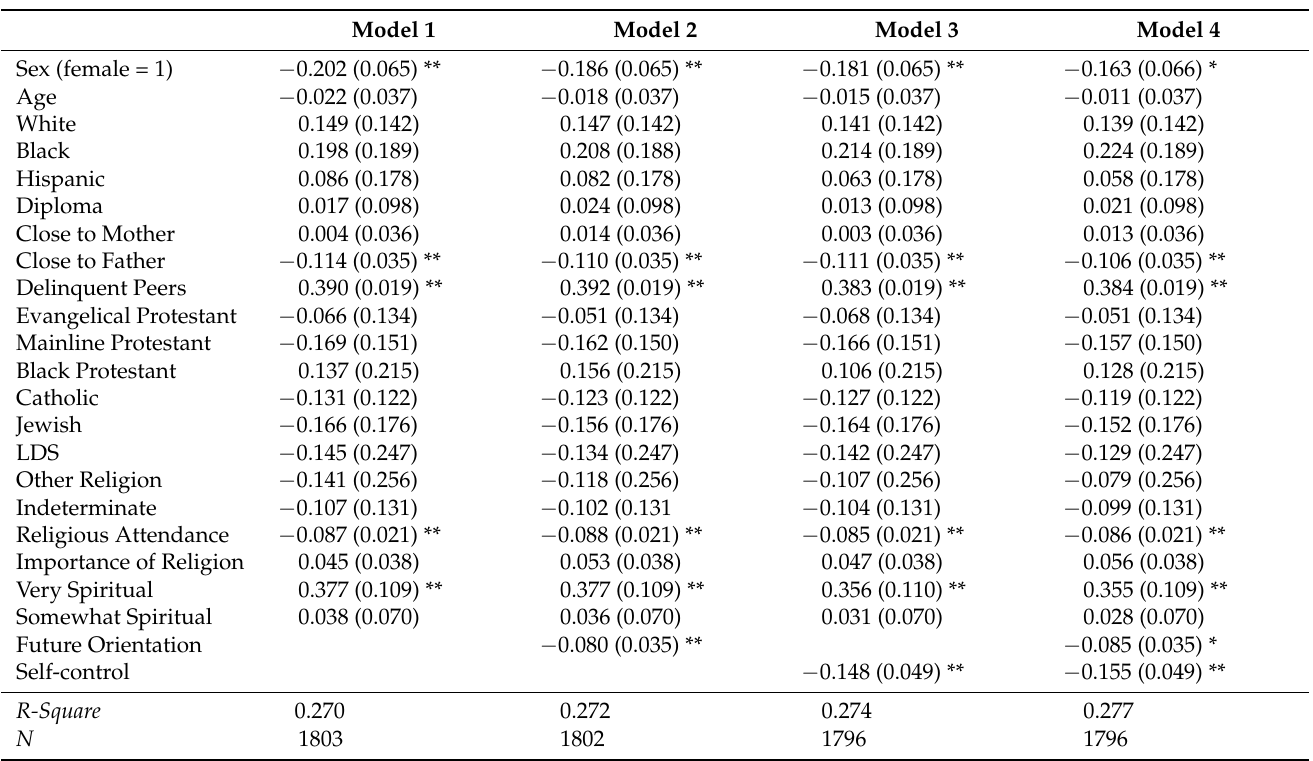
Table 3. OLS Regression of Religiosity, Future Orientation, Self-control, and Marijuana Use (Standard